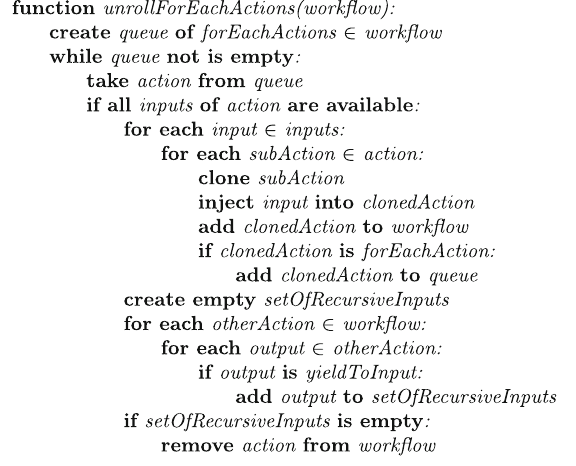
Fig. 8 The function unrollForEachActions clones sub-actions as many times as there are iterations and then removes the corresponding for-each